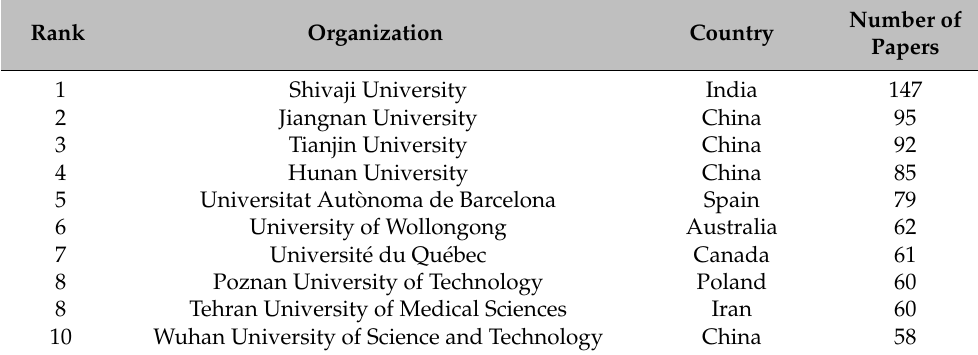
Table 3. Top 10 organizations working on laccase-assisted wastewater